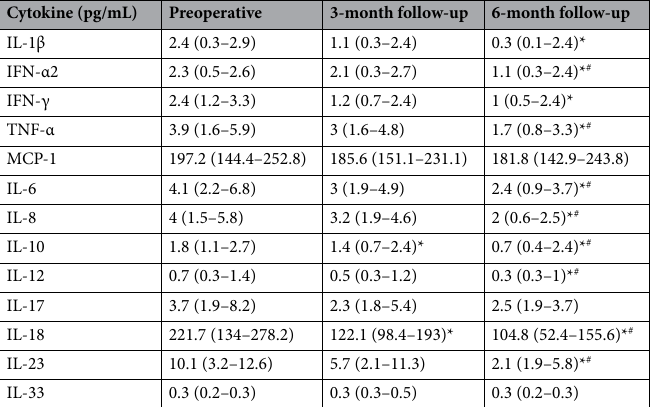
Table 3. Plasma cytokine concentrations in the patients before and after bariatric surgery. n = 32. IFN: Interferon, IL: Interleukin, MCP: Monocyte Chemoattractant Protein, TNF: Tumor Necrosis Factor. Data is presented as median (IQR), *p-value < 0.05 vs preoperative, # p-value < 0.05 vs 3-month follow-up. Friedman test with post-hoc pairwise Nemenyi